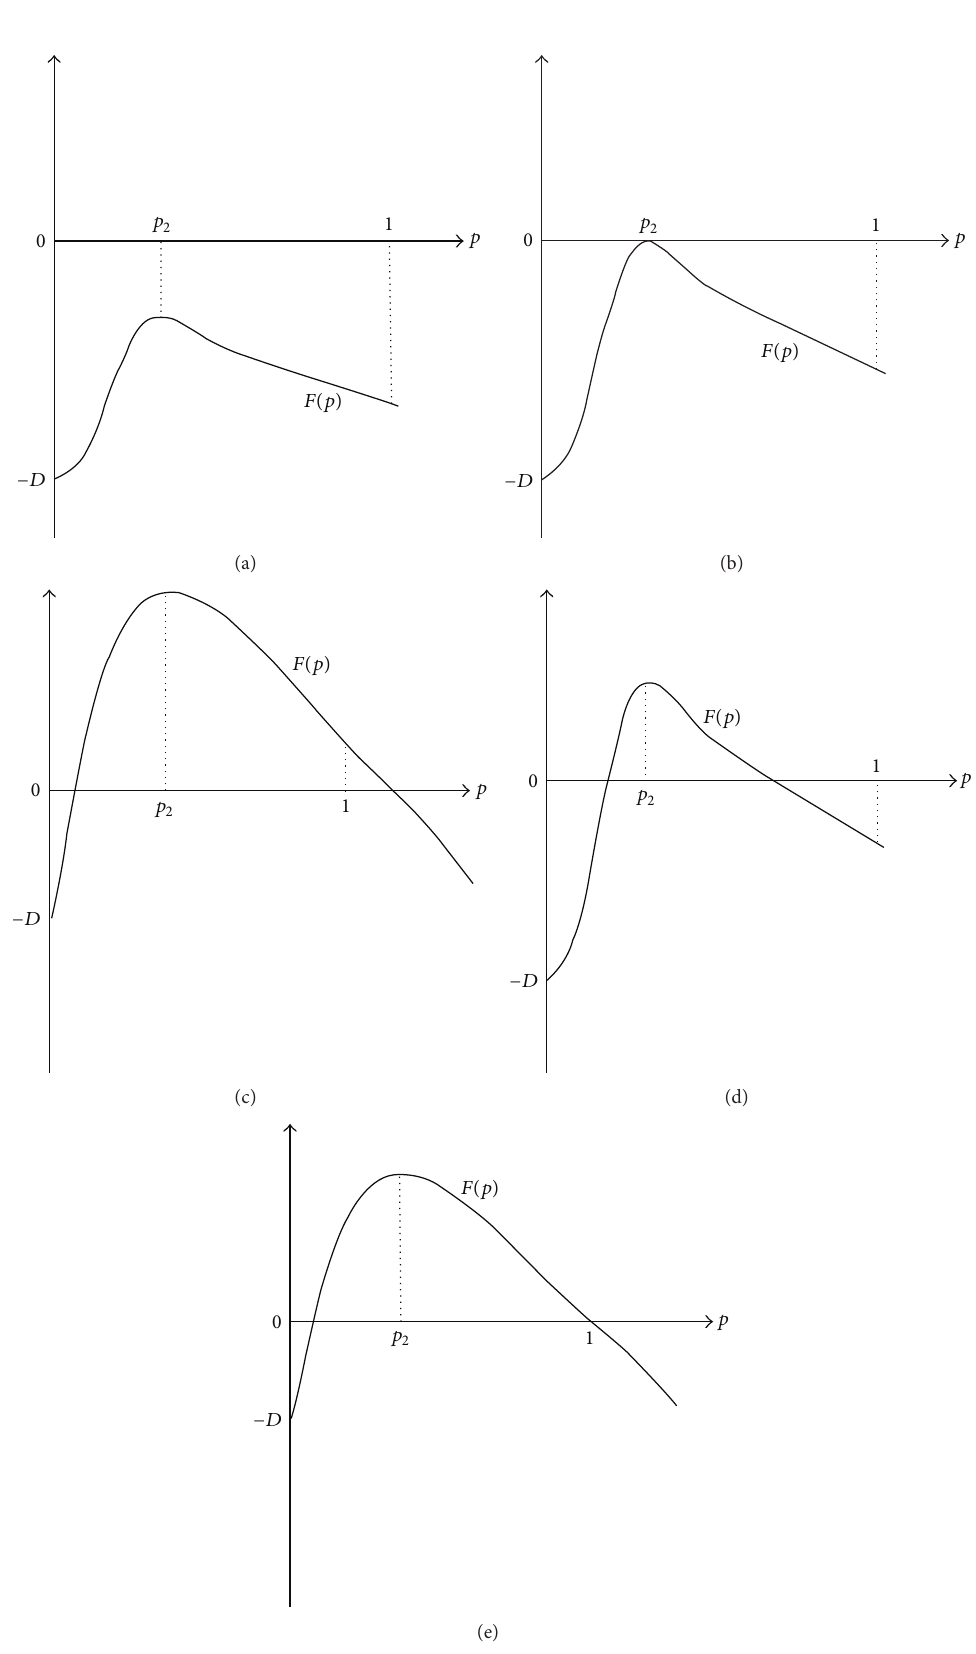
Figure 1: The graph of function 𝐹(𝑃) = 0